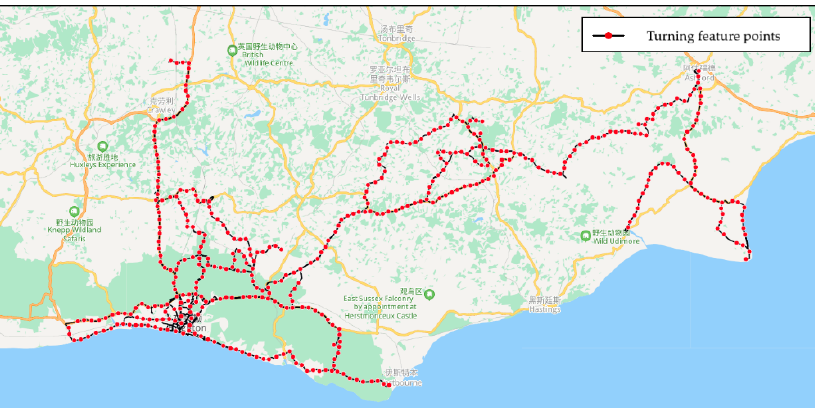
Figure 16. The extraction results of turning feature points under the 5 m compression threshold.